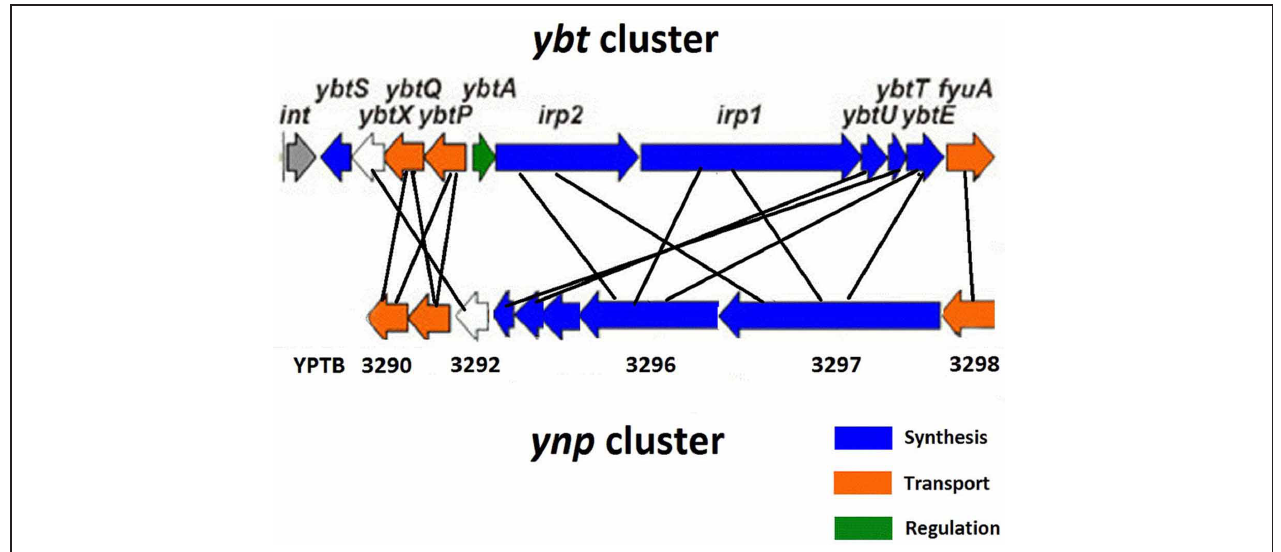
FIGURE 2 | Comparison of the ybt and ynp iron acquisition clusters in Y. pseudotuberculosis IP32953.